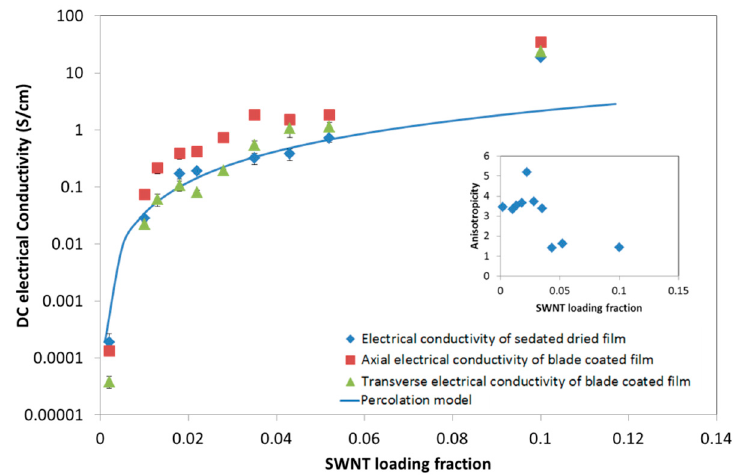
Figure 10. Electrical conductivity of sedated and blade sheared dried SWNT/CNC films as a function of SWNT volume fraction. The blade sheared film conductivity was measured in the direction of shear (axial) and perpendicular to shear (transverse). The inset is the anisotropicity (ratio of axial and transverse electrical conductivity) of blade-coated film conductivity at different SWNT loading fractions.